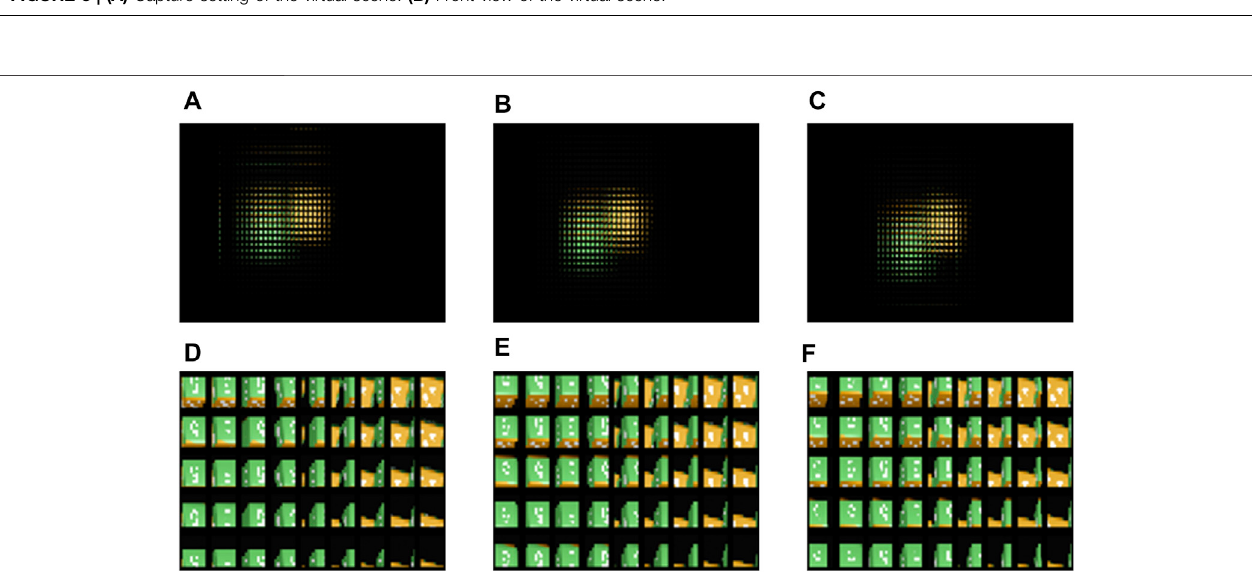
FIGURE4| EffectoftheSPOCalgorithm:the fi rstrowfromlefttorightistheoveralldisplay effectcorrespondingtotheraypassingthroughthe (A) upperedge, (B) center, and (C) lower edge of each synthetic lens. (D) – (F) are the corresponding central magni fi cation renderings.